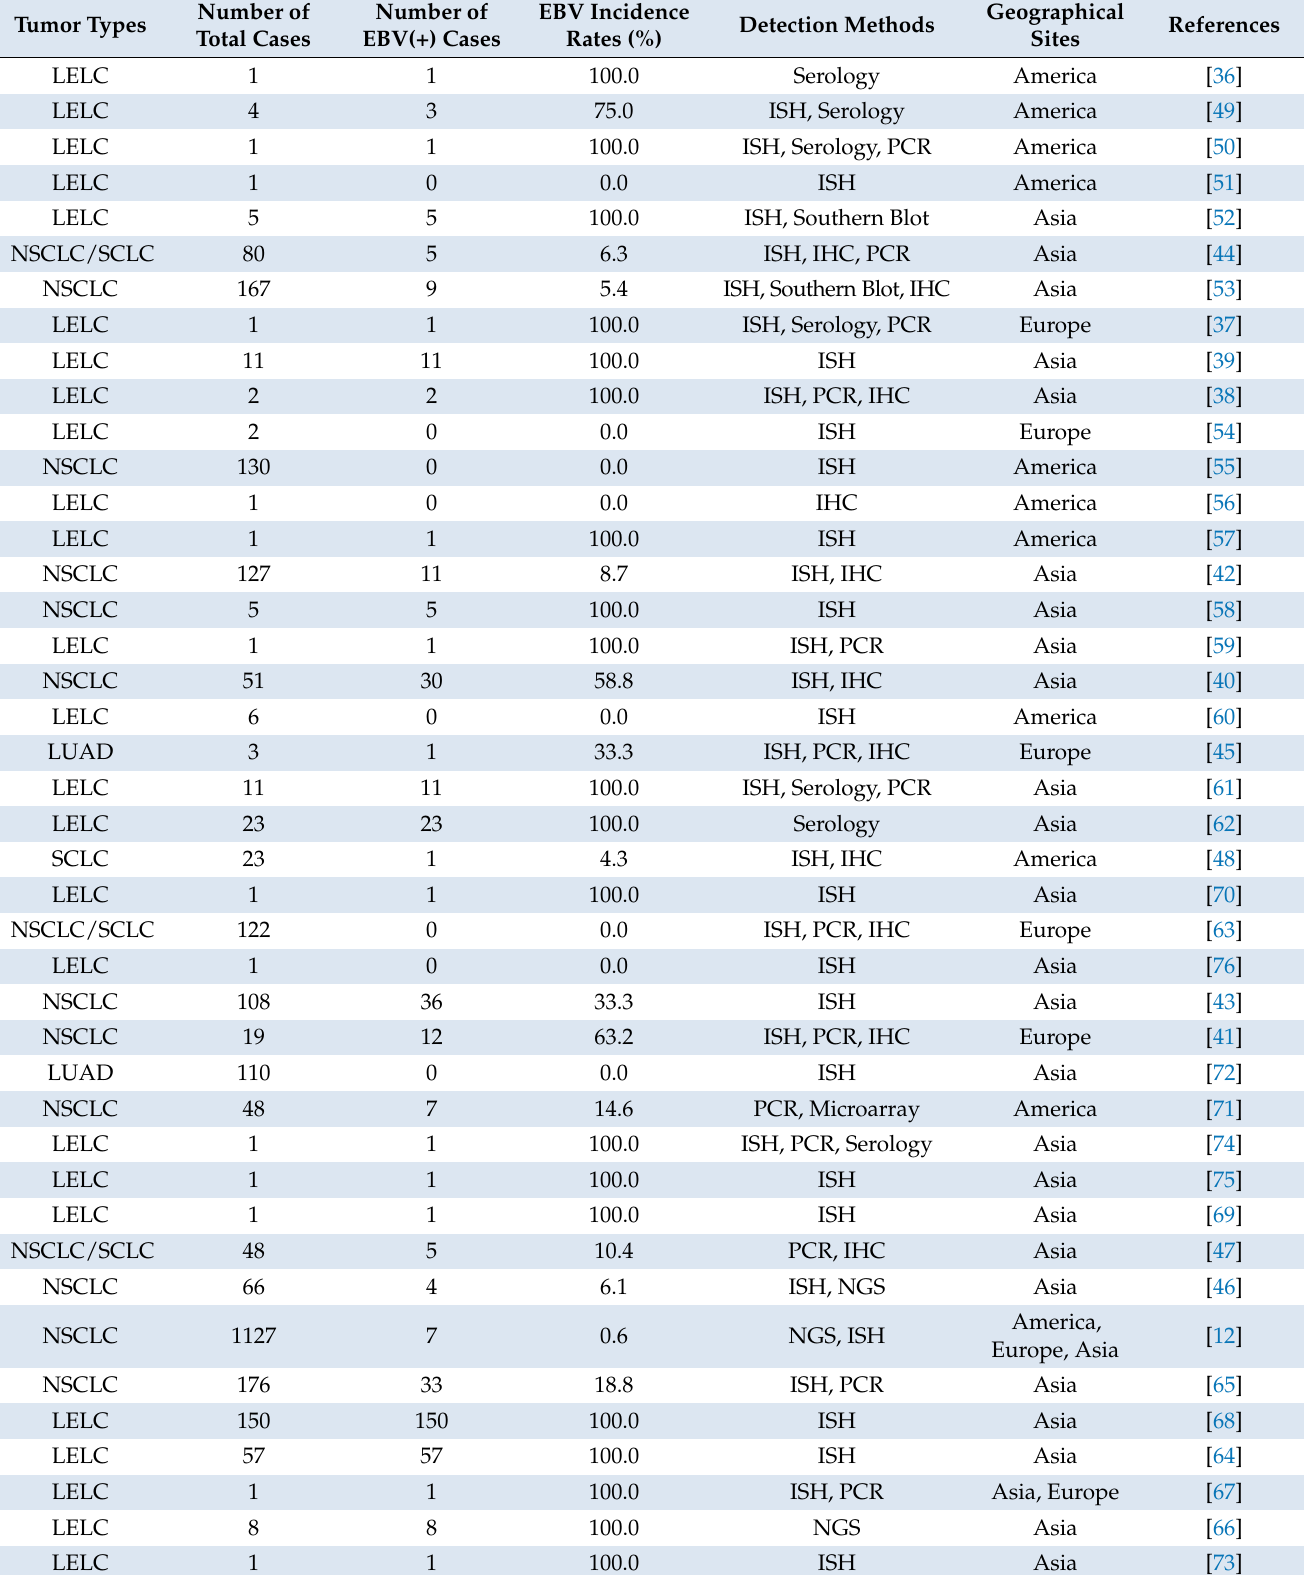
Table 2. Association between EBV infection and lung